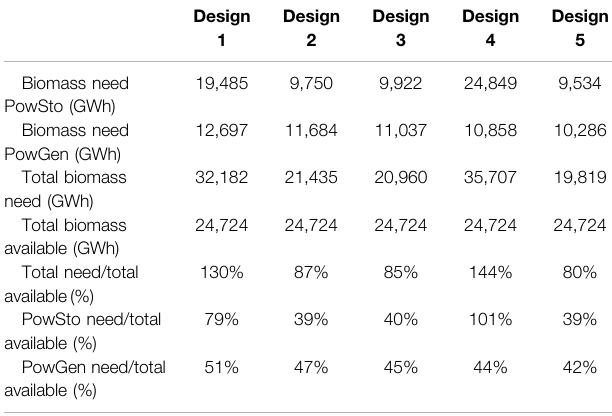
TABLE 5 | Comparison between the residual loads and the local (in-around SUD) biomass waste and residue availability, in terms of energy content, by adopting W2G technology in the fi ve proposed